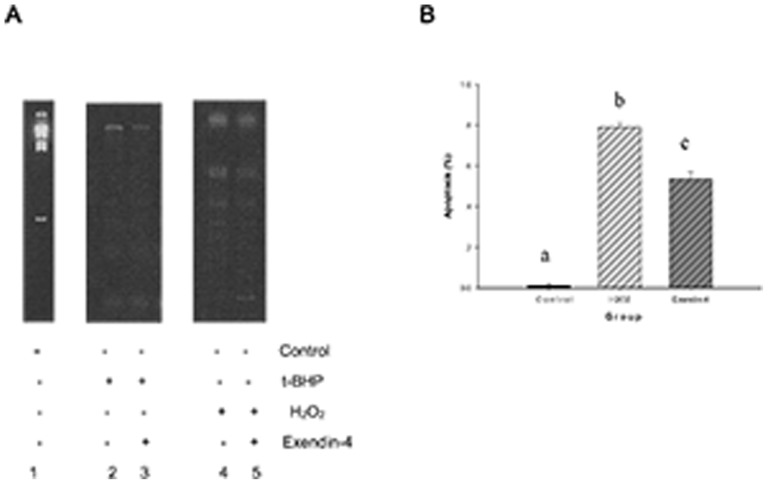
Exendin-4 reduced H2O2-induced Min6 cell DNA fragmentation.A, Apoptotic DNA ladder analysis. fter t-BHP (200 µM for 24 hours, as in Figure A2) and H2O2 (100 µM for 24 hours, as in Figure A4) treatment, the DNA was purified using an apoptosis DNA ladder kit and analyzed on agarose gel. Figures A3 and A5 represent Exendin-4 groups that were treated with t-BHP or H2O2 after treatment with Exendin-4 100 µM for 48 hours. Figure B is a summary of the results and includes the gray comparison among the control group, the H2O2 (100 µM for 24 hours) group and the Exendin-4 group. The data are expressed as the means±S.D. (n = 6). a, b and c indicate the respective comparisons (p<0.05).